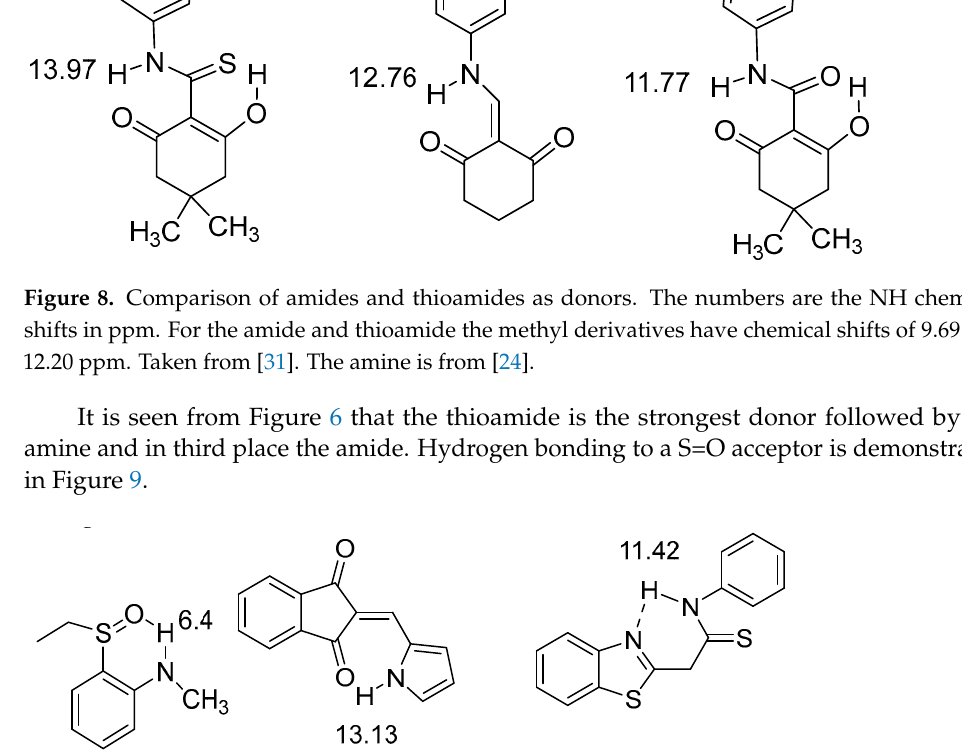
Figure 9. Hydrogen bonding with different motifs. The numbers are NH chemical shifts in ppm. The sulfoxide is from [32]. The indole derivative is from [33]. Other similar motifs is seen in this reference. The benzo[d]thiazol is from [28].